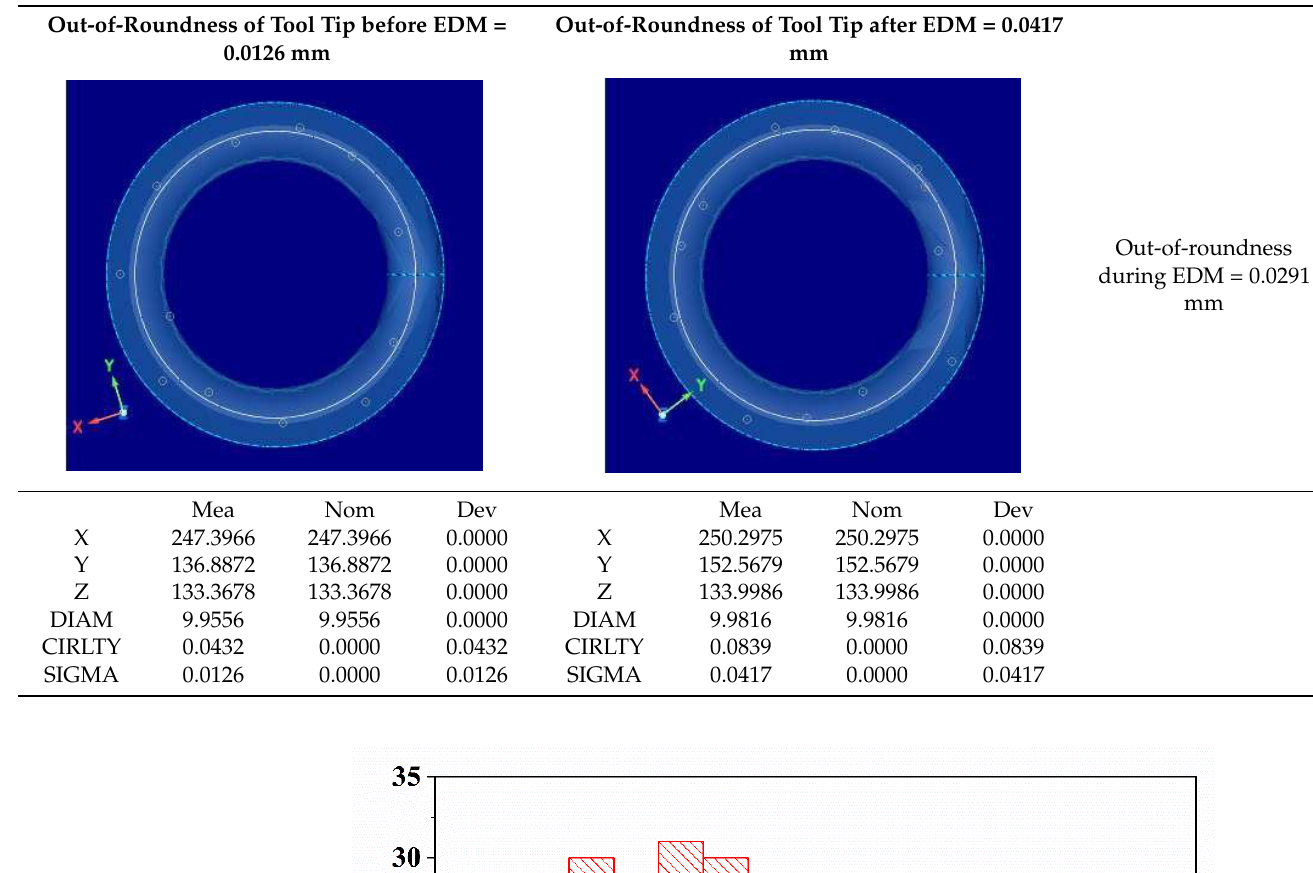
Table 5. Out-of-roundness of the tool tip before and after machining (I p = 9 A, V g = 50 V, T on = 200 µs, T off = 20 µs, P = 18 kgf/cm 2 ).